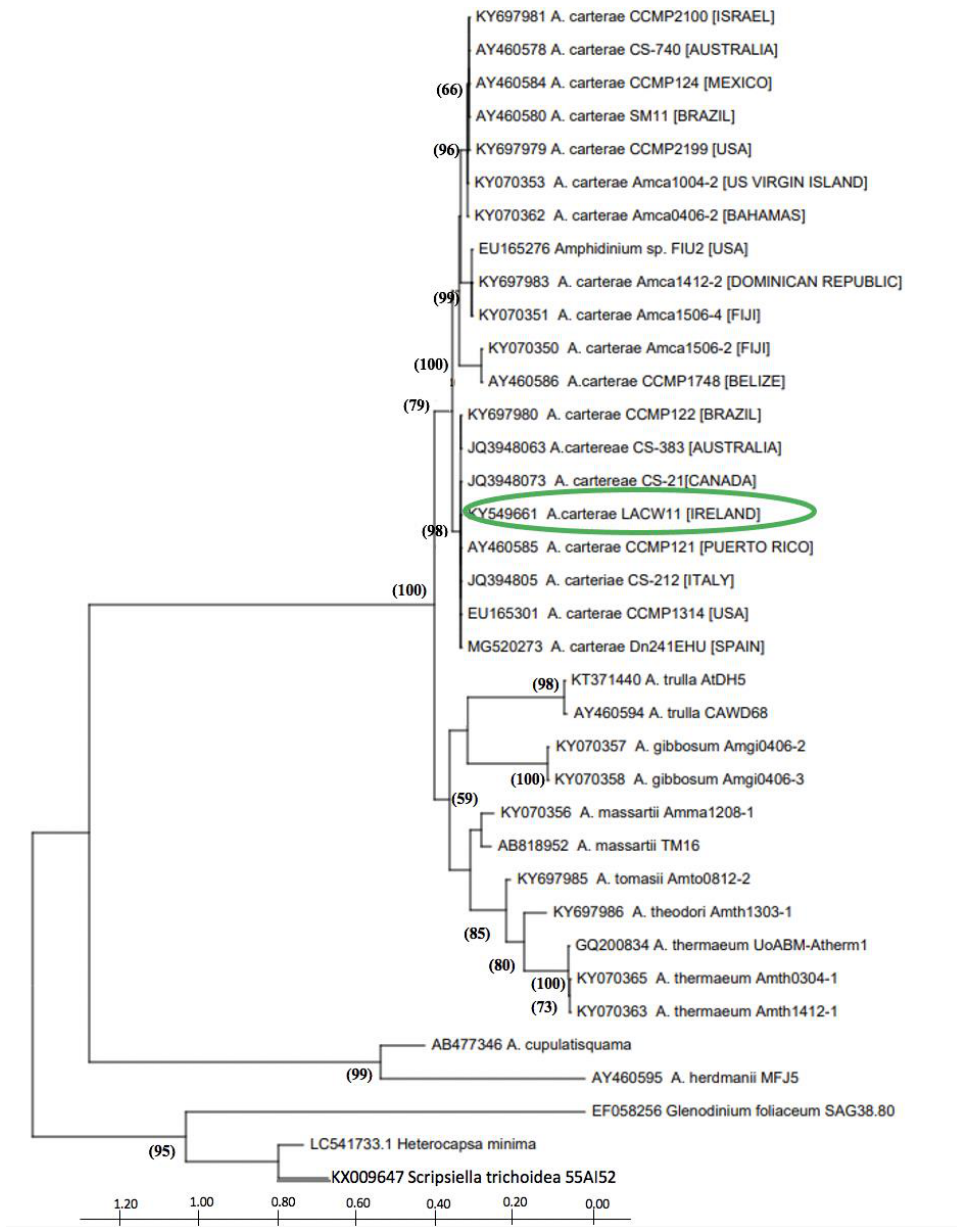
Figure 1. Phylogenetic tree inferred from the maximum likelihood analysis of partial LSU rDNA sequences of Amphidinium species. The optimal base substitution model derived from the Bayesian Information Criterion (BIC) using MEGA X was Tamure Nei gamma distributed (TN93 + G, parameter = 0.4032). Bootstrap values (%) of 1000 replicates are shown (only values > 50). The position of strain LACW42 in the tree is highlighted in green.